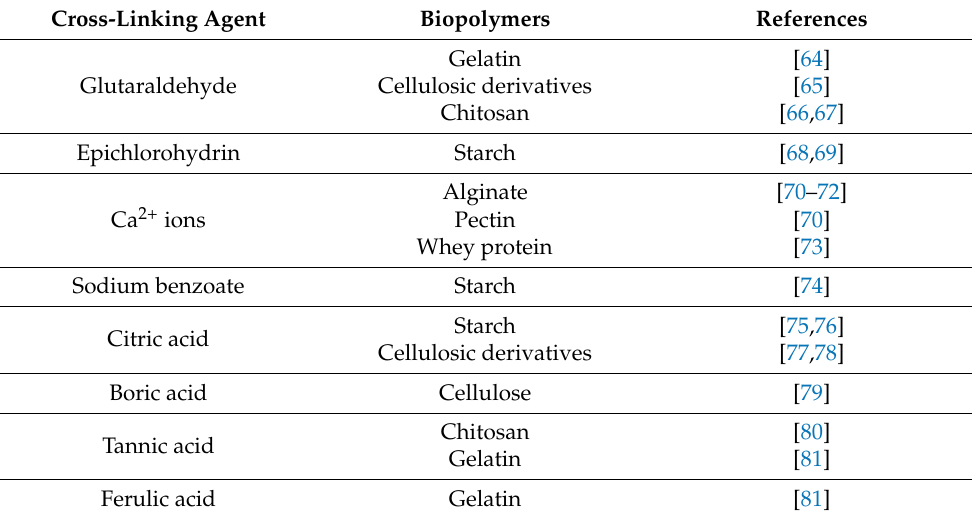
Table 2. Cross-linking agents commonly used in different types of edible